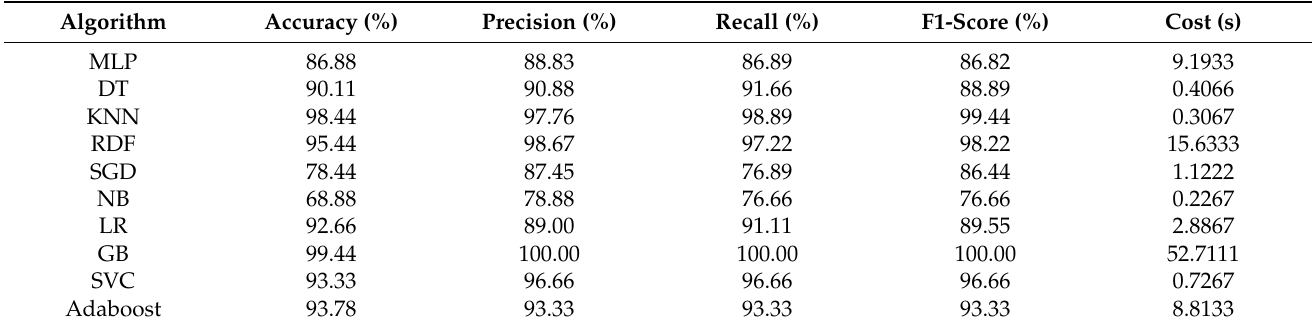
Table 7. Global performance comparison of ML models using loss coefficient (D) features.